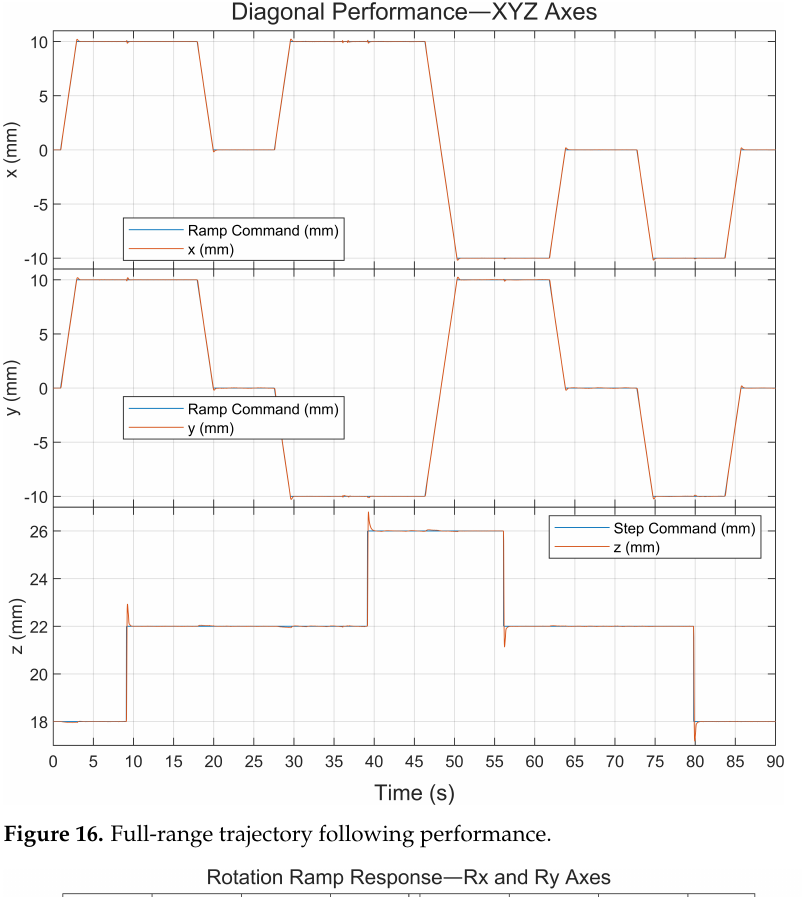
Figure 16. Full-range trajectory following performance.